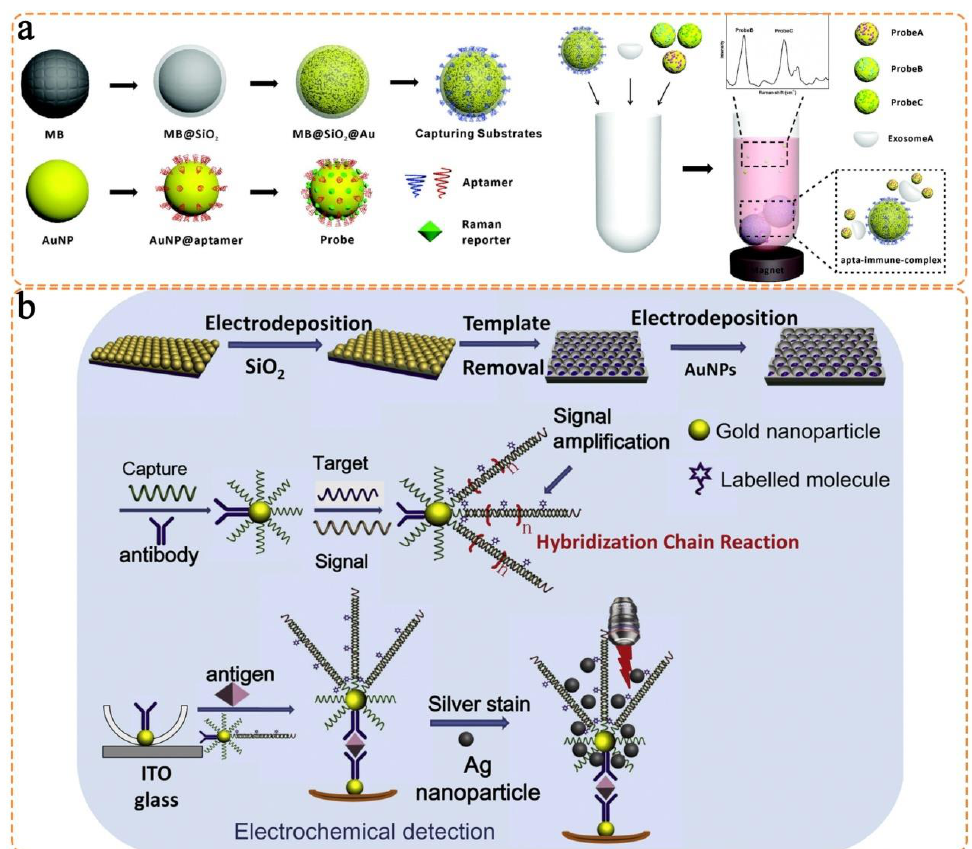
Figure 5. Gold nanosphere-based SERS nanotags for parallel biomarker detection. ( a ) Detection of three EVs together with magnetic nanobeads using the prepared three SERS nanotags (i.e., Probe A, Probe B, and Probe C). Reproduced with permission [49]. Copyright 2018, Royal Society